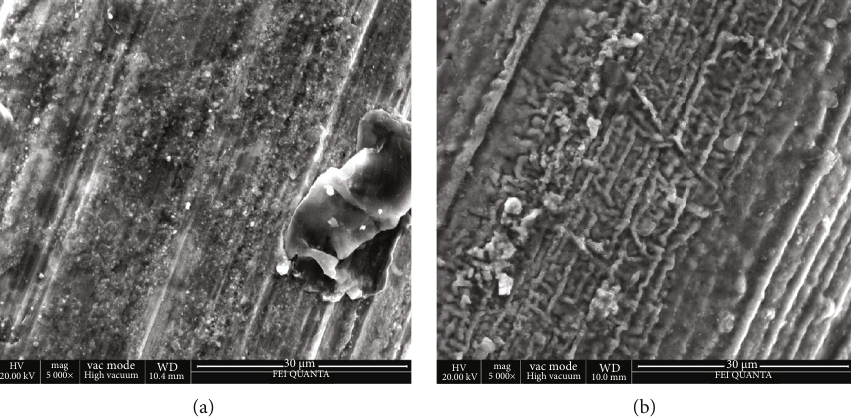
Figure 8: Surface morphology of heater surface: (a) 0.2% volume concentration Al